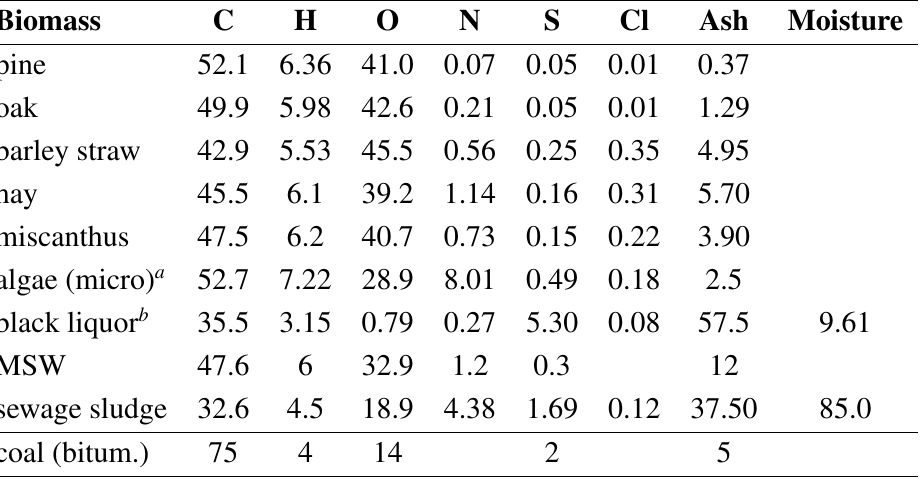
Table 2 . Main compositions of different kinds of biomass; coal listed for comparison